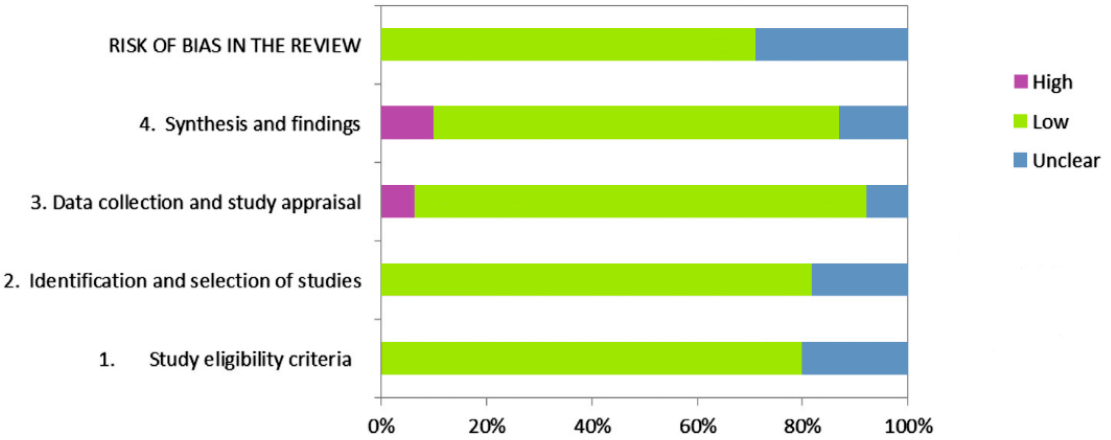
Figure 1. PRISMA flow diagram of the literature search and study selection process.